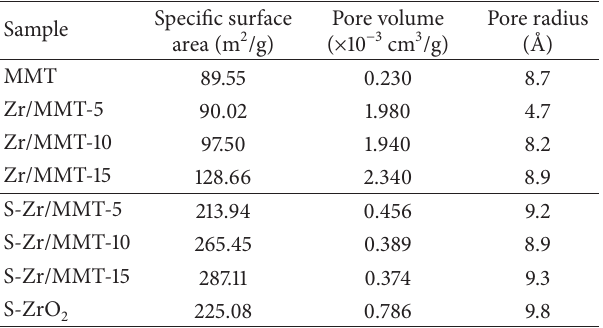
Table 2: Specific surface area, pore volume, and pore radius of